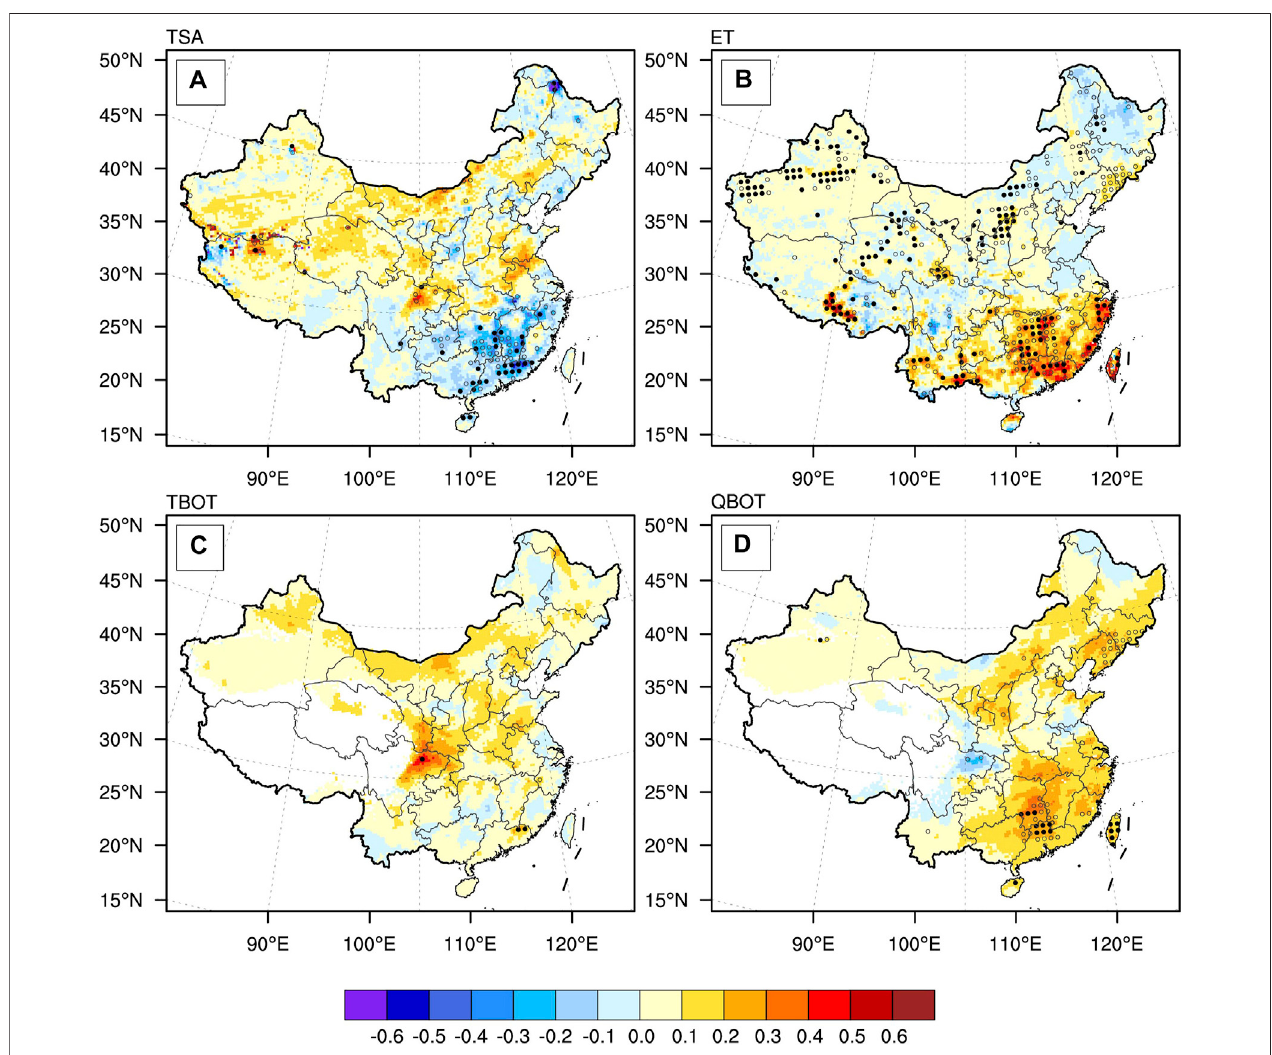
FIGURE 7 | The ensemble mean results of realistic LUCC-induced changes in multiple near-surface temperature and humidity variables in POF season during 1984 – 2013: (A) 2 m air temperature (units: ° C), (B) canopy evapotranspiration (units: 10 1 W m − 2 ), (C) atmospheric air temperature at the lowest model level (units: ° C) and (D) atmosphericspeci fi chumidityatthelowestmodellevel(units:g/kg).Themeaningofthesolid(hollow)blackdotsisthesameasin Figure5 .NotethattheLUCC- induced changes in the area above 3000 m are masked.